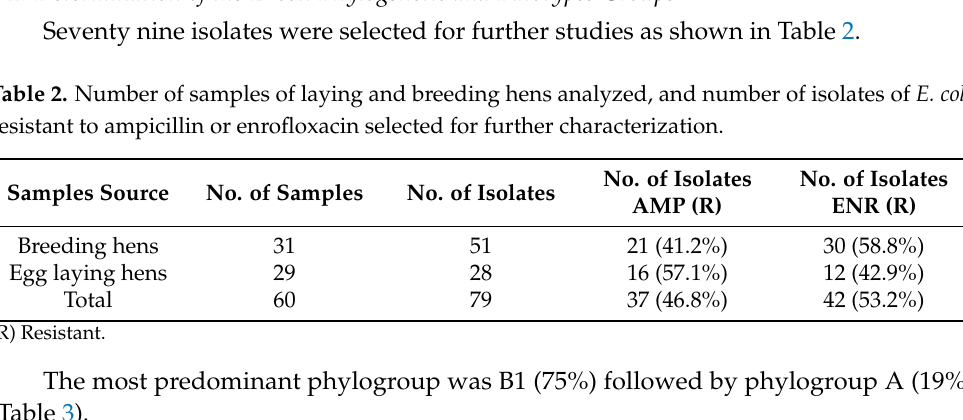
Table 3. Percentages of phylogroup detected in isolates from hens